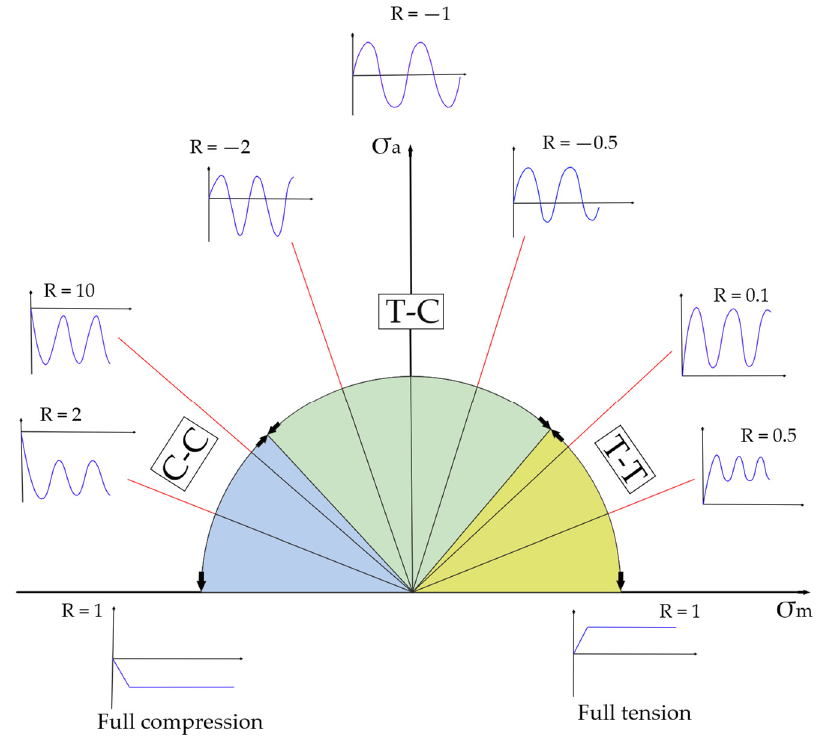
Figure 2. The CLD diagram illustration: A vertical axis—the alternate stress; A horizontal axis—the mean stress [21].